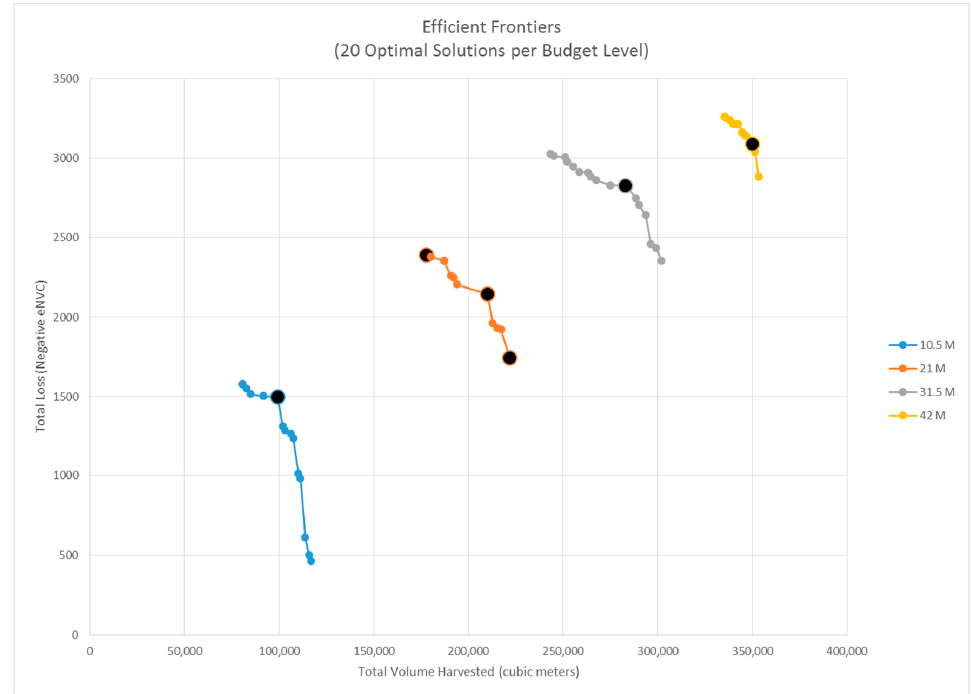
Figure 4. Efficient frontiers for fuel treatment strategies, across the four budget levels, with solutions selected for simulation highlighted.